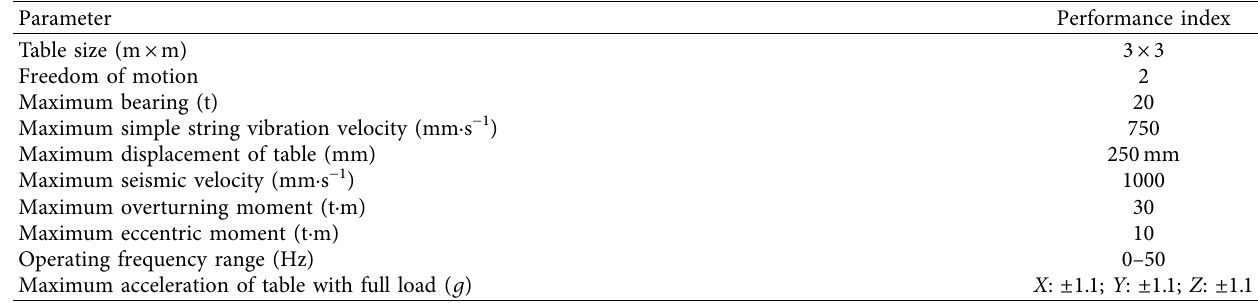
Figure 5: Rigid model box with built-in flexible material: (a) shaking table; (b) model box containing 40mm thick polystyrene foam board on the inner wall; (c) shaking table with model box installed; (d) overall view of the shaking table. Table 2: Performance parameters of the shaking